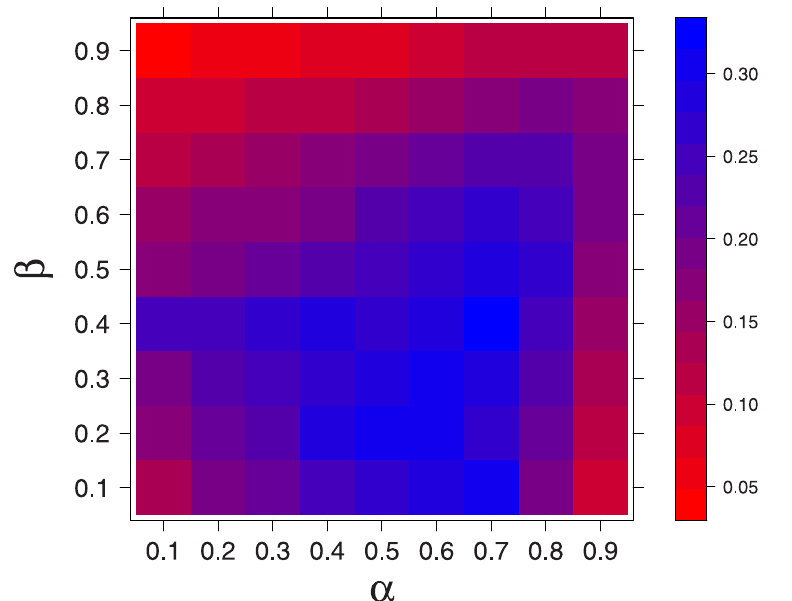
Fig 3. The average deviation between the original mother and the mother-like corrected daughter sequences ( � D ¼ ensemble averaged D ð M ; ^ M Þ ) is plotted for different α and β values as a heatmap (see color bar on the side). The error is averaged over the error of 300 mother sequences and 200 daughter sequences corresponding to each mother sequence—that is, 60000 D ð M ; ^ M Þ values. α represents the conditional probability of a nucleosome staying in 1 (modified state): P ( m = 1| m = 1). β represents the conditional probability of a nucleosome staying in 0 (unmodified i i − 1 state): P (